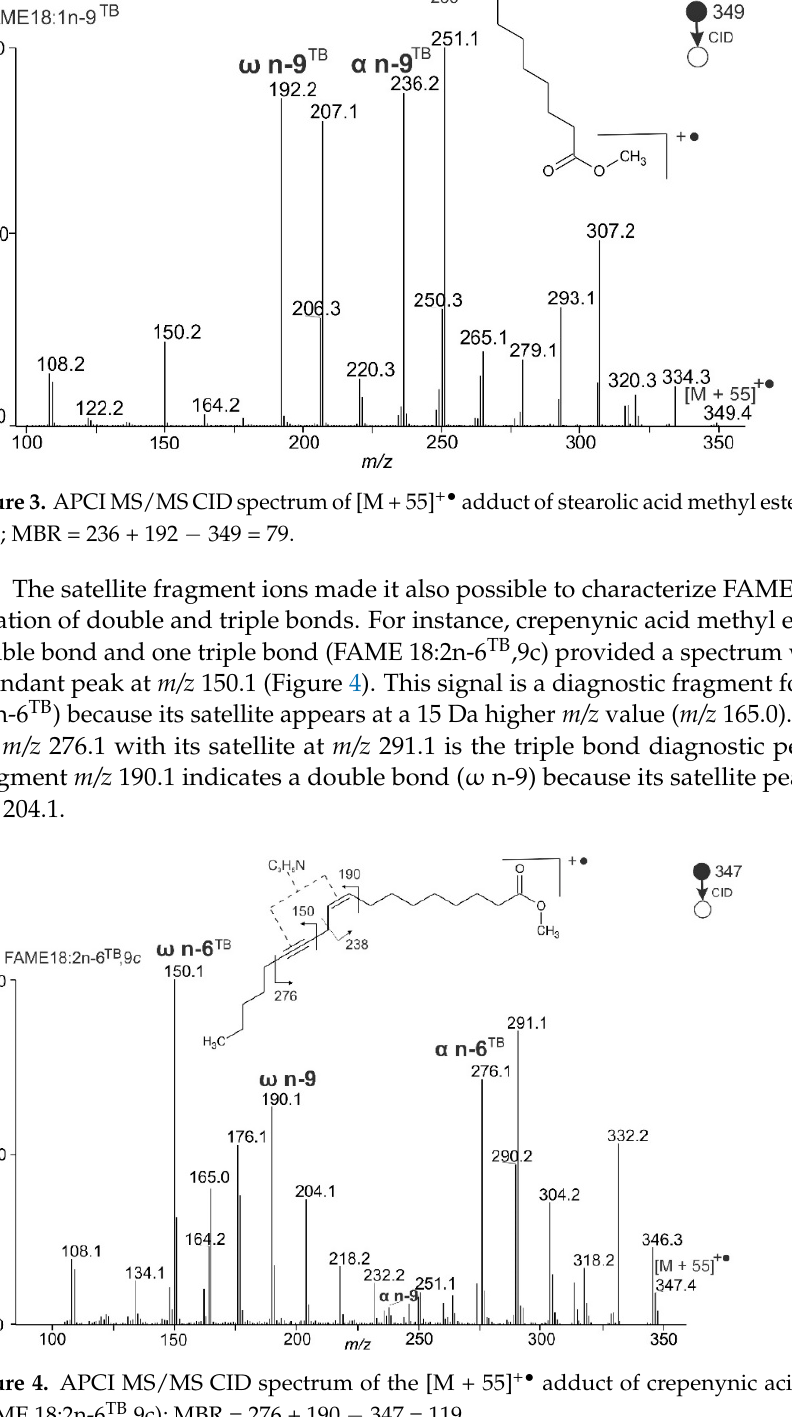
Figure 5. HPLC/APCI-MS base-peak chromatogram of FAMEs from the fat body of Bombus pratorum and the list of identified species.